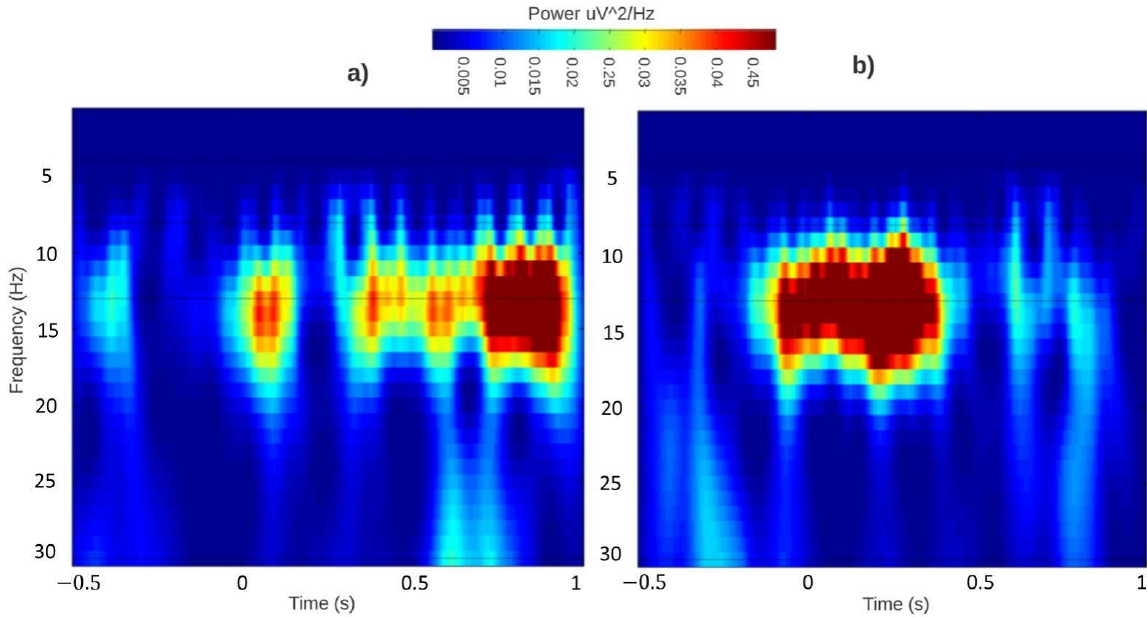
Figure 6. Control group. ERD/ERS responses over Fz before ( a ) and after ( b ) the sound-based treatment during the auditory recognition event. Fz was selected to illustrated central tendencies, since it is the clinical recording site to diagnose tinnitus.